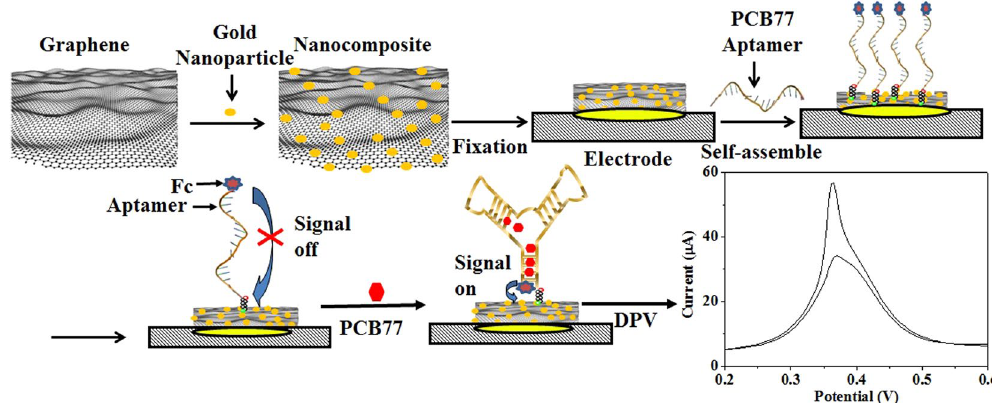
Figure 4. Schematic diagram of the fabrication process and detection mechanism of the RGO-AuNP-Ap/Au